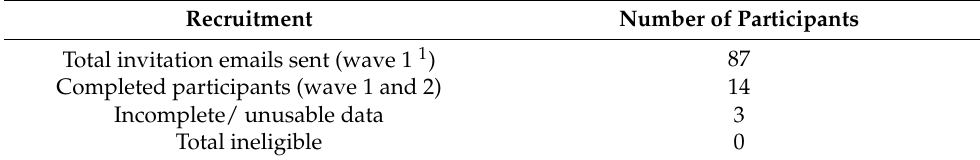
Table 1. Participant response outcomes.